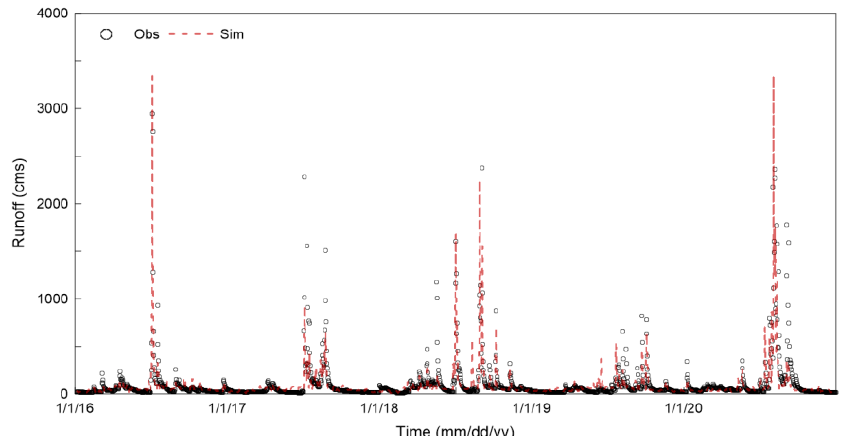
Figure 3. Validation results of the ANN model using a time-series of the observed and predicted runoff from 2016 to 2020.